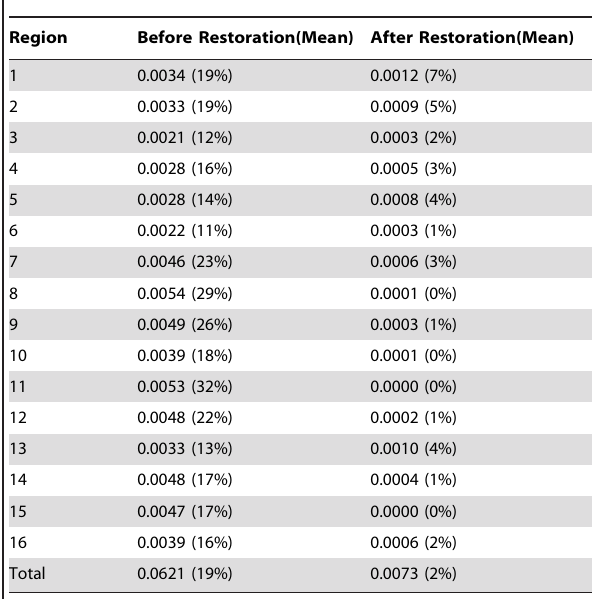
Table 4. Absolute Difference and Percentage Difference in Curvedness w.r.t Ground